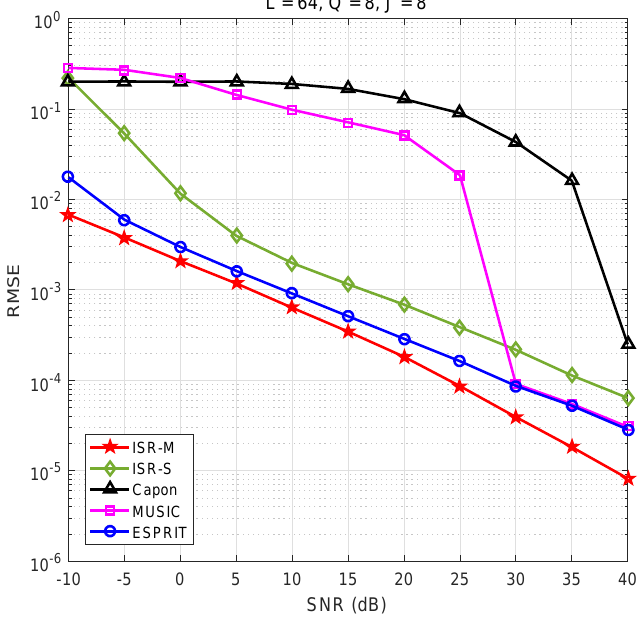
Figure 9. Comparison with existing MIMO radar target localization methods with K = 3, L = 64, Q = 8, and J =